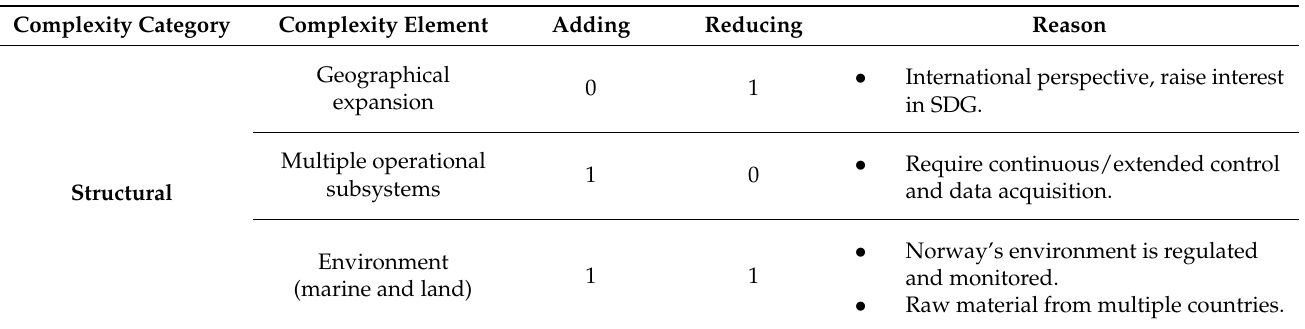
Table 5. NSVC system’s complexity in relation to SDGs.